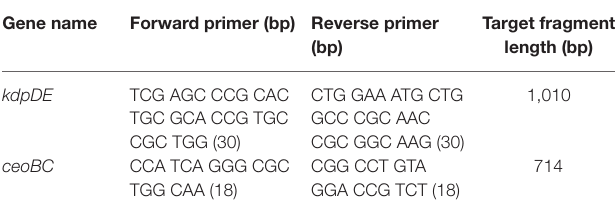
TABLE 2 | Primers used for probe preparation for Southern blotting for KT-double knockout mutant strain